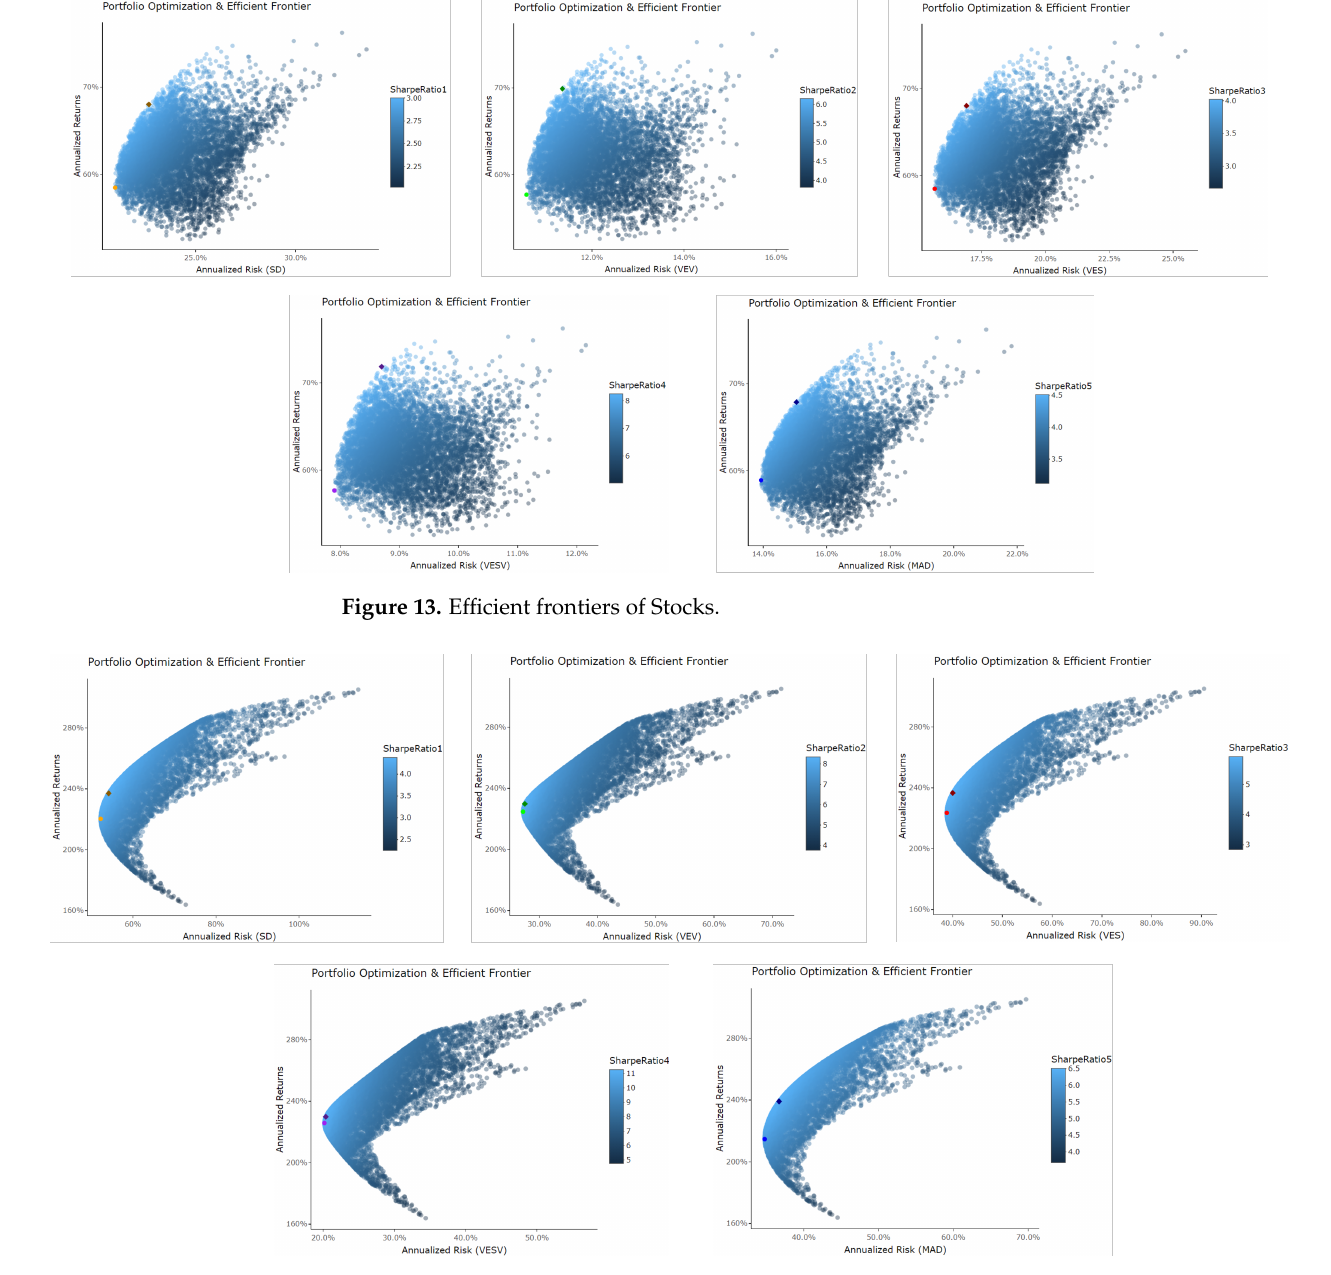
Figure 14. Efficient frontiers of Cryptocurrencies (Group